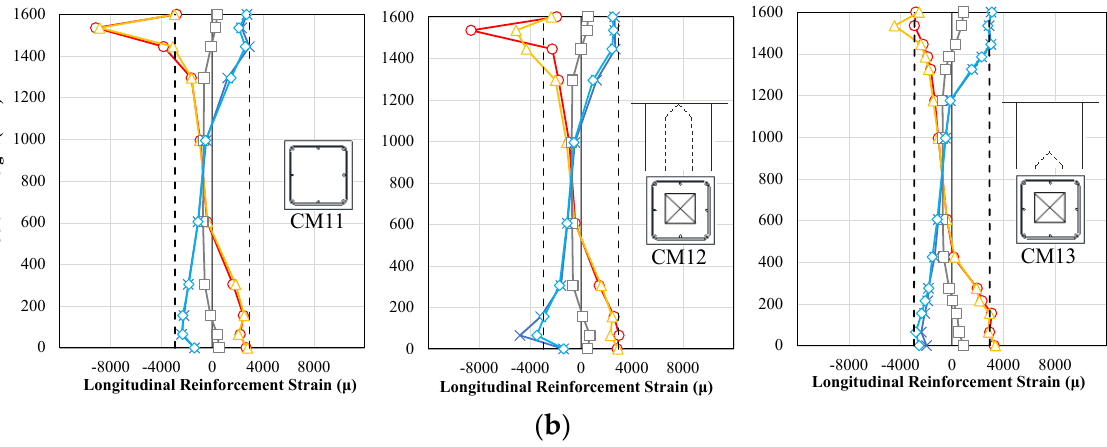
Figure 8. Strain distributions of longitudinal reinforcement ( R = 1.0%): ( a ) N-series; ( b ) S-series. Strain gauges were also attached to the transverse reinforcement to understand the effect had by the use of hollow cross-sections. Figure 9 shows the strain distributions of the transverse reinforcement in each specimen at R = 1.0%. Strain distributions at No.1~No.3 are expressed in red, green, and light blue, respectively. Comparing CM1 and CM2 of the N-series, with solid and hollow sections, the strain distributions were found to be approximately the same in both specimens. Since CM11~CM13 of the S-series, with a higher axial force ratio, showed the same tendency, the effects of hollow sections on transverse reinforcement strains are also considered to be small when the columns fail in the flexural dimension.